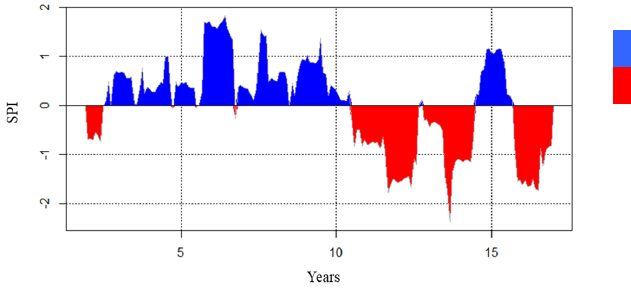
Figure 12. Twelve ‐ month SPI (years: 2000–2015). Figure 12. Twelve-month SPI (years: 2000–2015). Figure 12. Twelve-month SPI (years: 2000–2015).